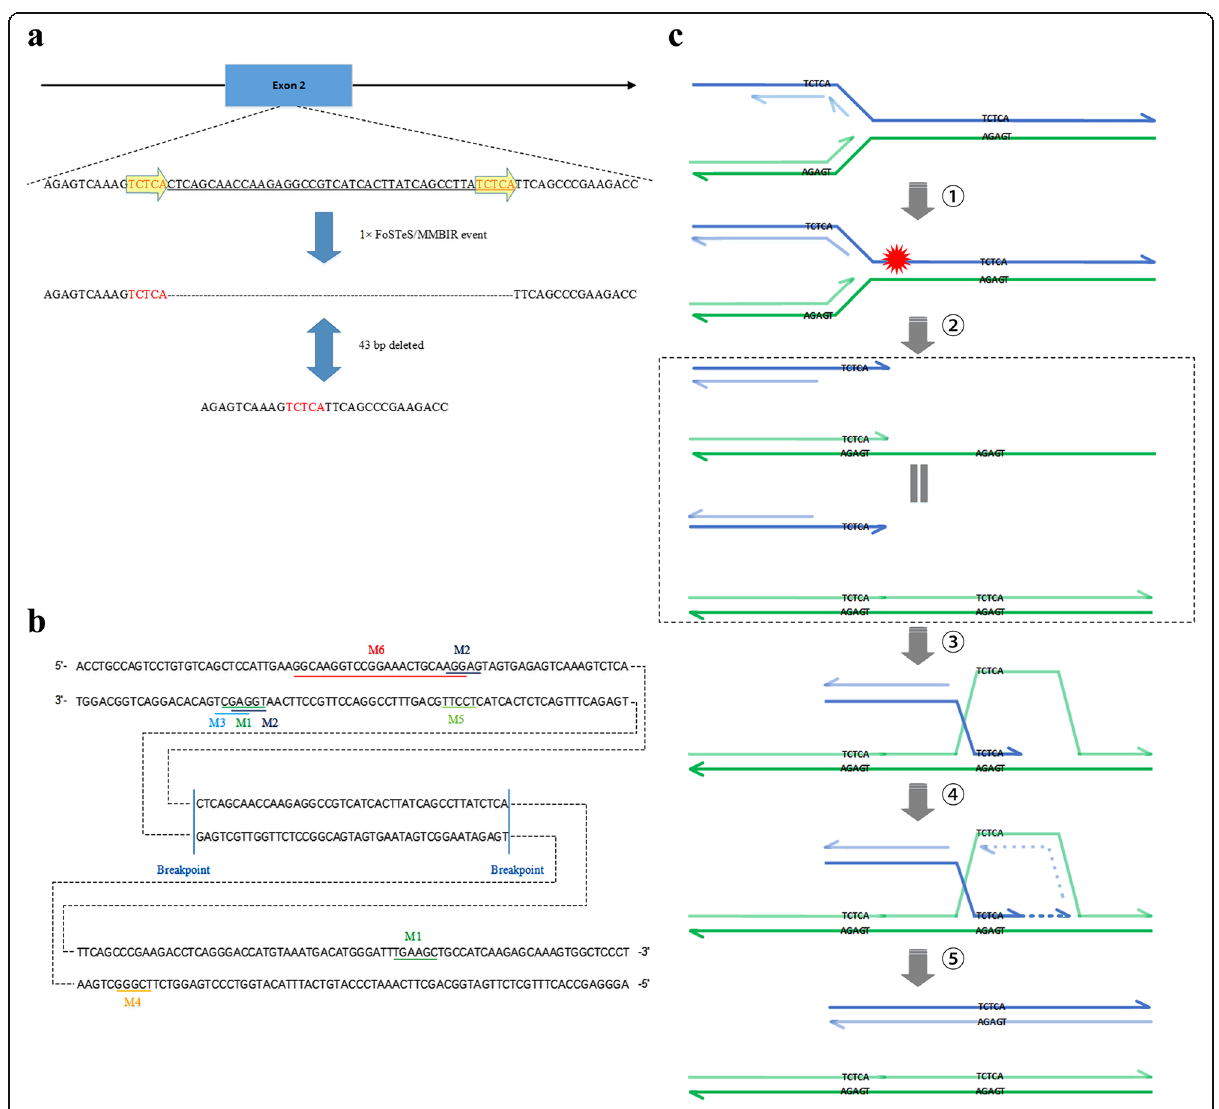
Fig. 2 Potential molecular mechanisms underlying the formation process of the c.532_574del mutation in the ATP7B . a Junction sequence analysis of the 43-bp deletion identified. Five base-pairs of microhomology sequence (TCTCA) were found at both breakpoints. Sequencing re- vealed that one FoSTeS/MMBIR event caused the deletion during two microhomologies. b The presence of sequence motifs, non-B DNA confor- mations, or repetitive elements increased susceptibility to DNA breakage or promoted replication fork stalling. M1, deletion hotspot consensus (TGRRKM), green underline; M2, DNA polymerase arrest site (WGGAG), dark blue underline; M3, Ig heavy chain class switch repeat 1 (GAGCT), light blue underline; M4, Ig heavy chain class switch repeat 2 (GGGCT), orange underline; M5: Vaccinia topoisomerase I consensus (YCCTT), light green underline; M6, oligo(G)n tracts, red underline. c Illustrative explanation of the formation process of the c.532_574del mutation in the ATP7B gene based on FoSTeS/MMBIR mechanism during DNA replication. ① When a replication fork encounters a nick (Red hexagonal star) in a template strand (Blue), an arm of the fork breaks off, producing a collapsed fork. ② At the double-strand end, the 5 ′ strand (Light blue) is resected, yielding a 3 ′ overhang (Blue) with the microhomology sequence TCTCA at the terminus. ③ The 3 ′ single-strand end (Blue) invades the sister chromatid (Green and Light green) in the wrong way so that the microhomology sequence TCTCA (Blue) binds to the base complementary pairing sequence AGAGT of a single strand (Green) of the sister chromatid in the back rather than in the front, forming a D-loop. ④ New replication fork, with both leading and lagging strand replication, was reformed. ⑤ A Holliday junction was present at the site of the D-loop. Migration of the Holliday junction or other helicase activity, separating the extended double-strand end from its templates (Green and Light green). Finally, the replication fork becomes fully mature and continues replication to the chromosome end, which leads to the generation of the c.532_574del mutation. Each line represents a DNA nucleotide chain (strand). Polarity is indicated by half arrows on 3 ′